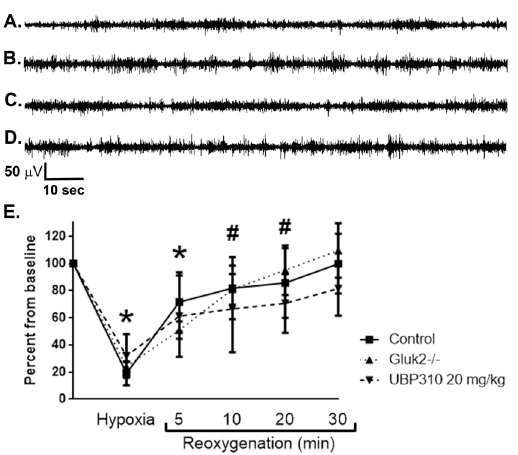
Figure 3. Effects of hypoxia on background EEG characteristics in control, GluK2 − / − and UBP310-treated neonatal mice. ( A–D ) Representative hippocampal EEG traces at baseline demonstrating background EEG patterns in control mice ( A ); GluK2 − / − mice ( B ); and control pre- and post-UBP310 injection in the same animal ( C and D , respectively). In all groups, background activity consisted of an almost continuous pattern with interspersed sharps and brief periods of low amplitude activity. ( E ) Exposure to 4% hypoxia for 4 min and 30 sec resulted in significant background attenuation in control ( n = 11), UBP310-treated ( n = 14) and GluK2 − / − mice ( n = 8; * p < 0.0001 vs. baseline in all groups, ANOVA). A progressive return to baseline was observed over the first 30 min of reoxygenation. Background activity remained significantly suppressed at 5 min in all groups ( * p < 0.0001 vs. baseline in all groups, ANOVA) and at 10 and 20 min after start of reoxygenation in GluK2 − / − and UBP310-treated mice ( # p < 0.0001 vs. baseline, ANOVA). By 30 min after the start of reoxygenation, background activity was not different than pre-hypoxia. There was no significant difference between groups either with degree of background suppression or timing of return to baseline ( p = 0.869, ANOVA). For all analyses of the effects of hypoxia on background EEG activity, sections of EEG without artefacts or seizures were selected at predetermined time points as indicated in the method section. Data shown as percent mean ±